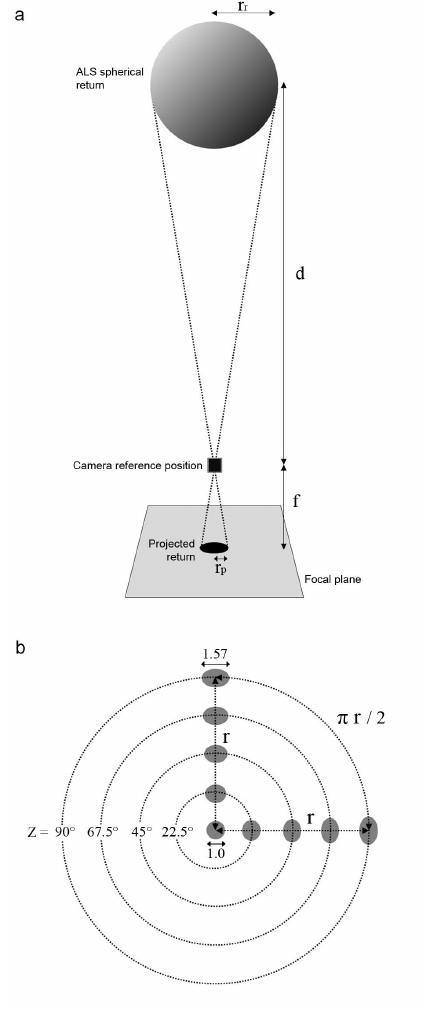
Fig. 3. Example of the projection of an ALS spherical return into a 2-D focal plane ( a ), and azimuthal radial distortion correction at representative zenith angles ( b